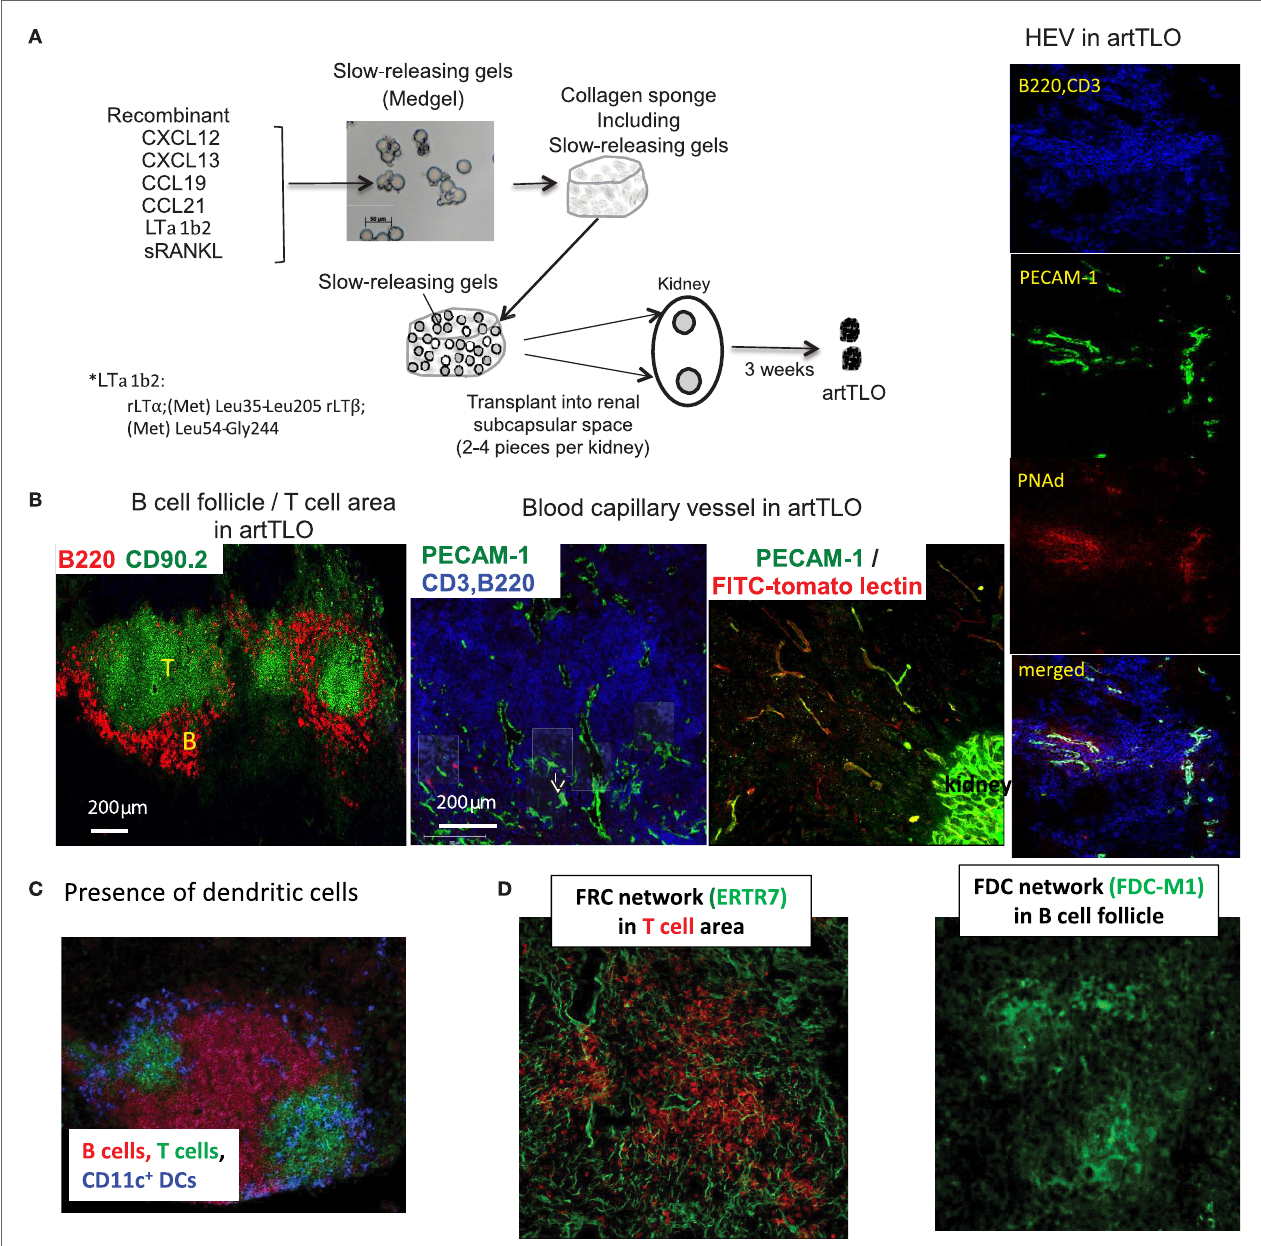
FigUre 1 | strategy to construct functional artTlOs . (a) The slow-releasing gel-beads (Medgel) containing each recombinant chemokine and cytokine protein indicated in the Figure were prepared. Briefly, solution (100 μ g/ml) of each soluble recombinant protein (CXCL12, CXCL13, CCL19, CCL21, LT α 1 β 2, and sRANKL) was added to the dry powder of the Medgel in 1.5 ml micro tube, respectively, and was incubated for 2 h at 37°C. Then, Medgels containing each chemokine and LT α 1 β 2 were combined and mixed. The combined gels were incorporated into the collagen sponges as described in the Section “Materials and Methods.” The collagen sponges were then transplanted into the renal subcapsular space of NP-OVA preimmunized Balb/c mouse. After 3 weeks, artTLO had formed. (B) Lymphoid cell assembly consisted of segregation of T cell area and B cell follicles. Functional capillaries and lymph vessels were detected. Functional arteries and high endothelial venules (HEV) were well developed. (c) Distribution of dendritic cells in T cell area. (D) FDC network in B cell follicle and FRC network in T cell